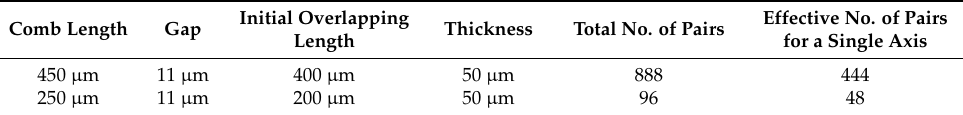
Table 1. Parameters for the comb-finger arrays in the